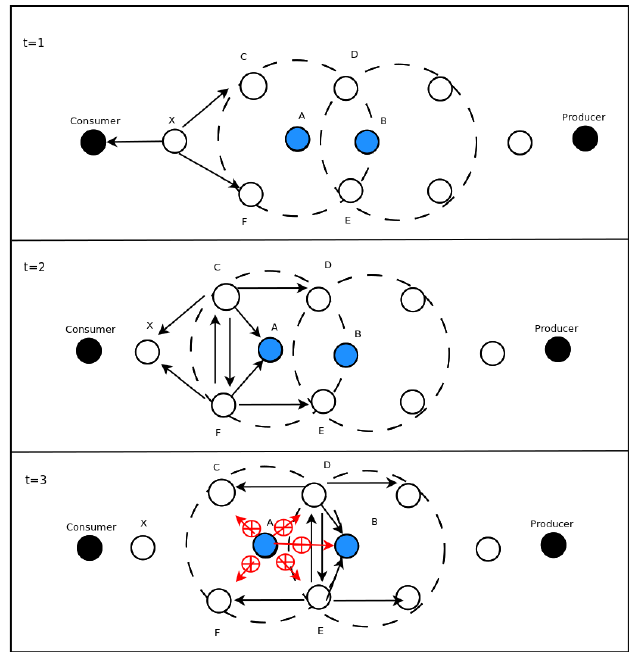
Figure 2. An example of the PIF mechanism in